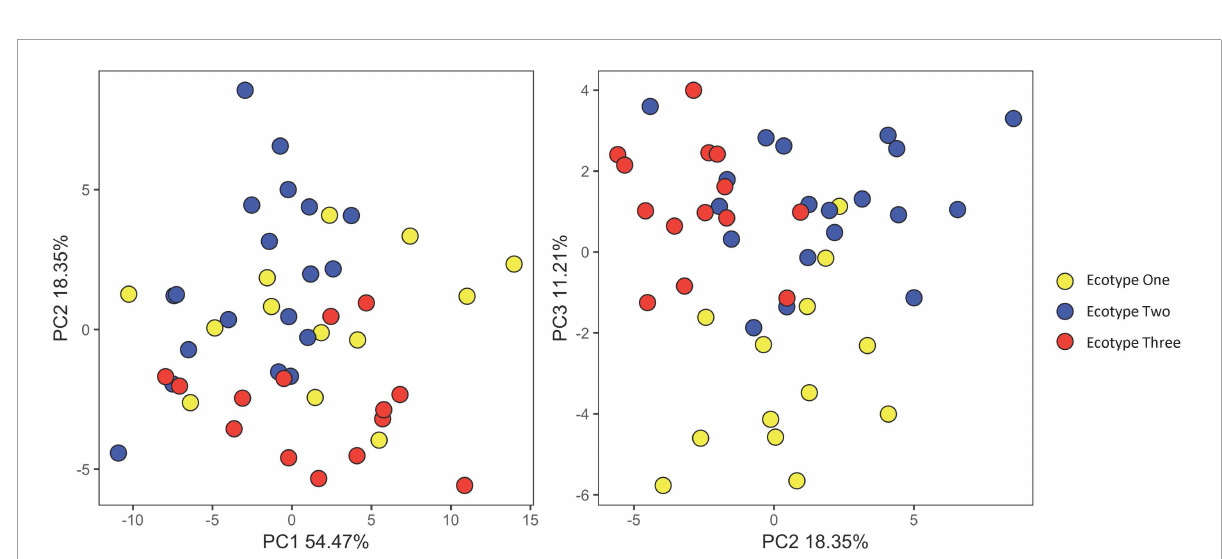
FIGURE5 Principal component analysis based off the 17 morphological traits measured for individuals of each ecotype of Drakaea livida